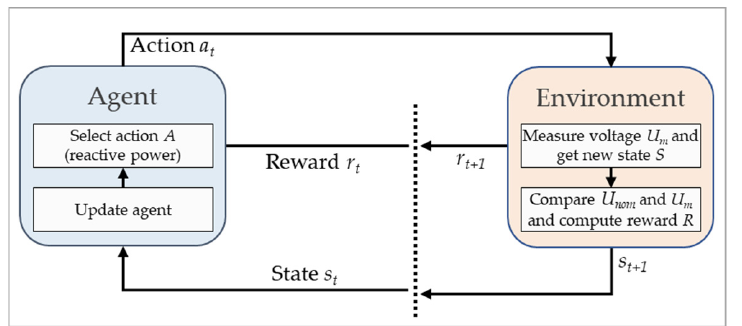
Figure 2. Interaction between agent and environment in reinforcement learning, according to [34]. The learning goal is to maintain the measured voltage ( U m ) close to nominal value ( U nom ) of 1 pu.